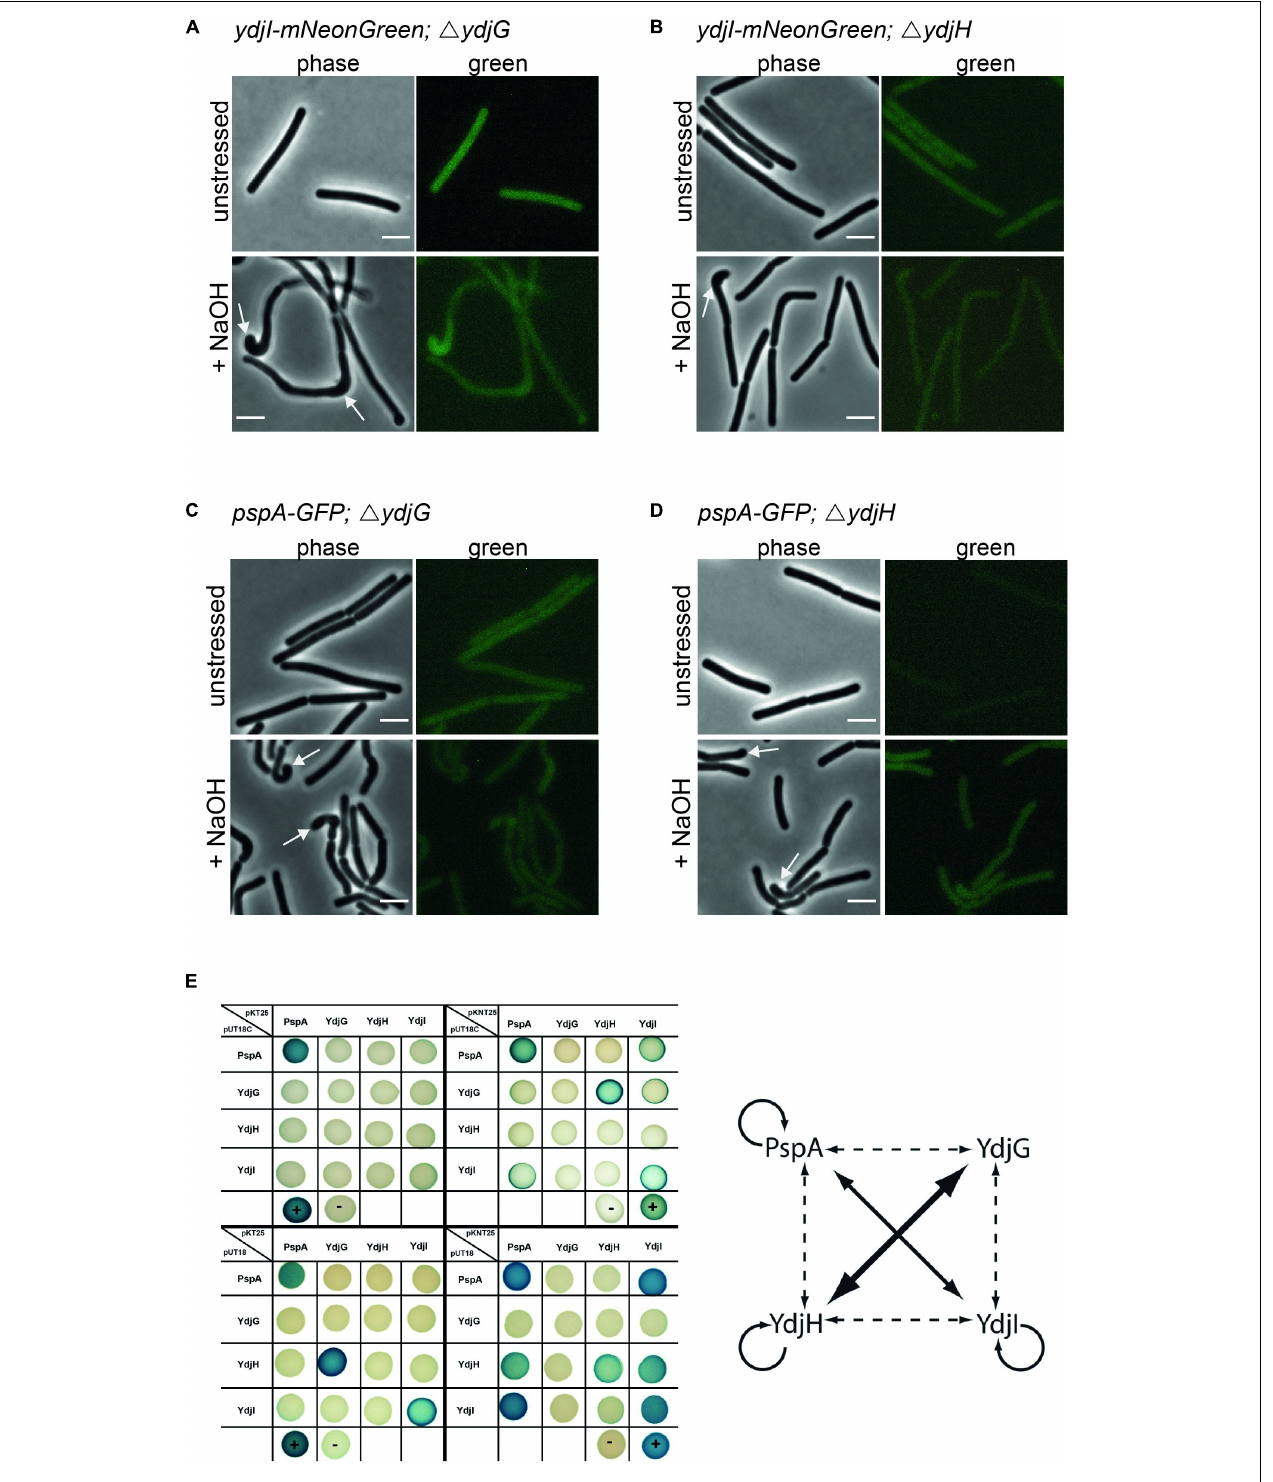
FIGURE 6 | YdjG and YdjH serve as membrane anchor for PspA-YdjI protein complex and seem to have a role in cell-shape maintenance. Deletion of (A) ydjG and (B) ydjH delocalize YdjI foci formation under both unstressed and alkali stress conditions. The same is shown for PspA delocalization upon deletion of (C) ydjG and (D) ydjH . Arrows indicate a strong cell-shape defect upon deletion of either YdjG or YdjH, under stress conditions. Scale bars: 3 µ m. (E) Interactions of proteins encoded in the pspA-ydjGHI operon via Bacterial-2-Hybrid. Blue colonies indicate protein–protein interaction, while in white colonies the target proteins do